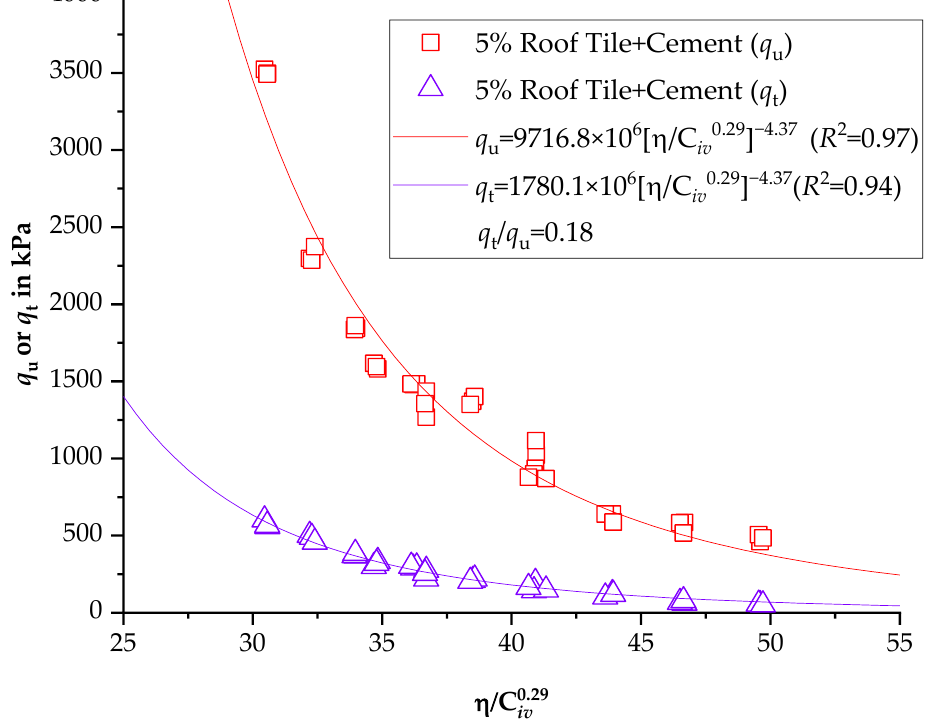
Figure 2. Variation of q u and q t with the porosity/volumetric cement ratio (using the exponent b = 0.29) for 5% of the roof tile waste.